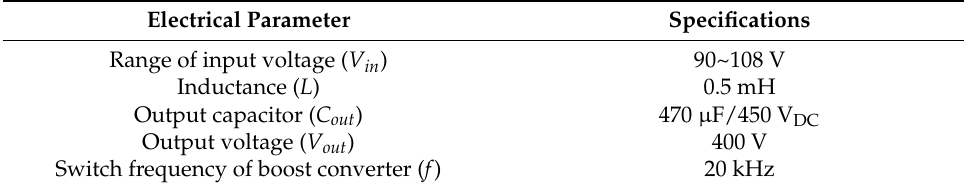
Table 1. The electrical parameters of the boost converter.